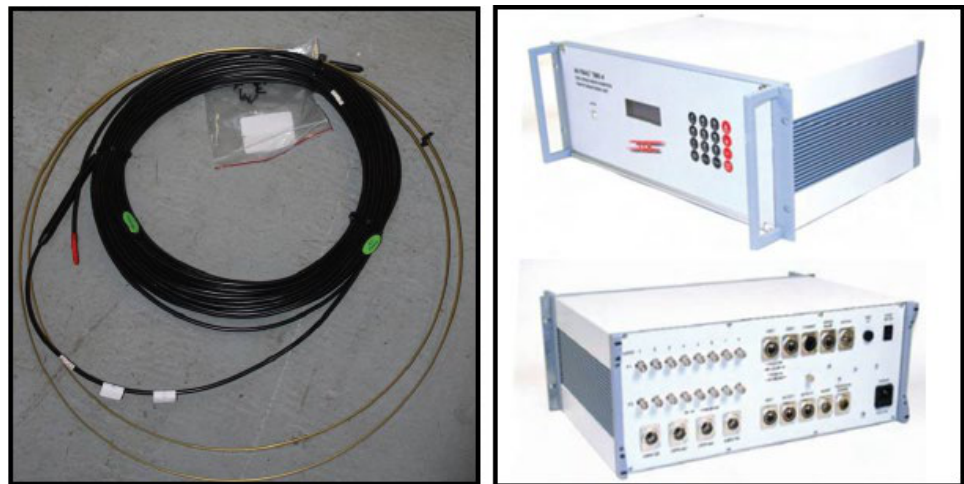
Figure 5. Sensors and data collecting system from BR-290 (adapted from Brito and Bock